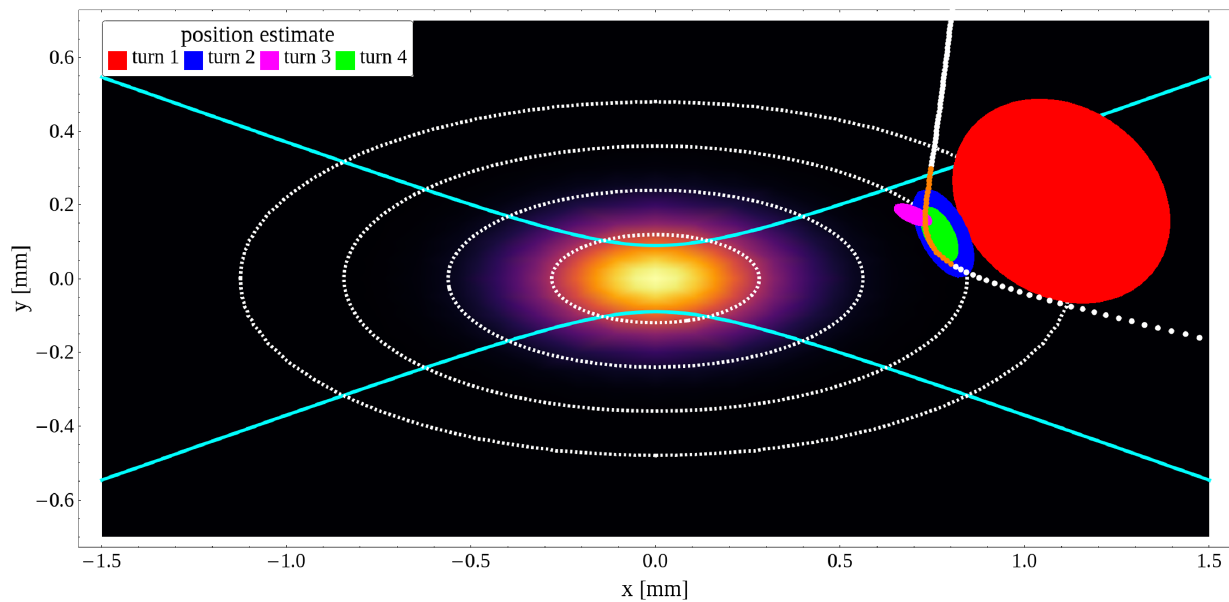
FIG. 14. Trajectory of the best fitting event from the simulations, compared to the estimated UFO position on a turn-by-turn basis. is shown as white dots. The orange part indicates the four turns up to and including the peak of the simulated losses.